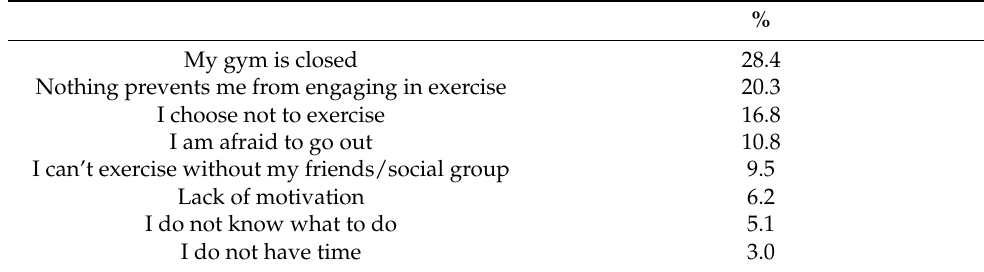
Table 5. Reasons for not engaging in physical activity or